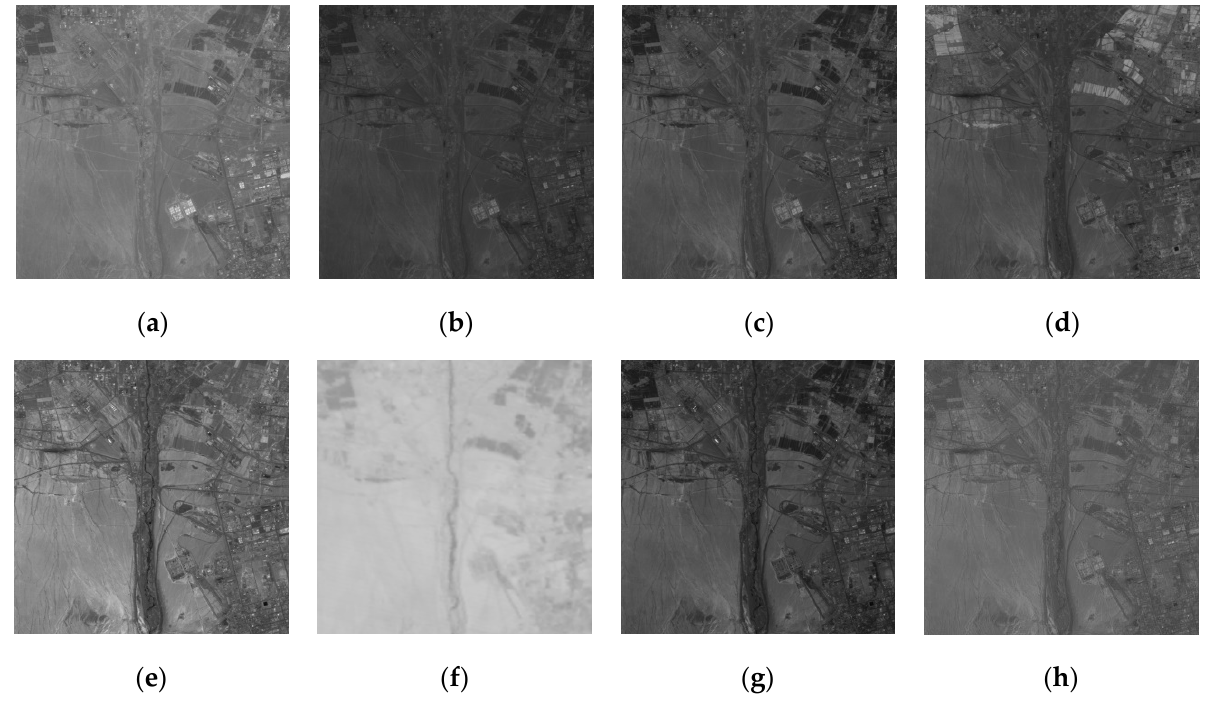
Figure 4. Original multispectral data 2 : ( a ) Band 1; ( b ) Band 2; ( c ) Band 3; ( d ) Band 4; ( e ) Band 5; ( f ) Band 6; ( g ) Band 7; ( h ) 7-bands composite image.